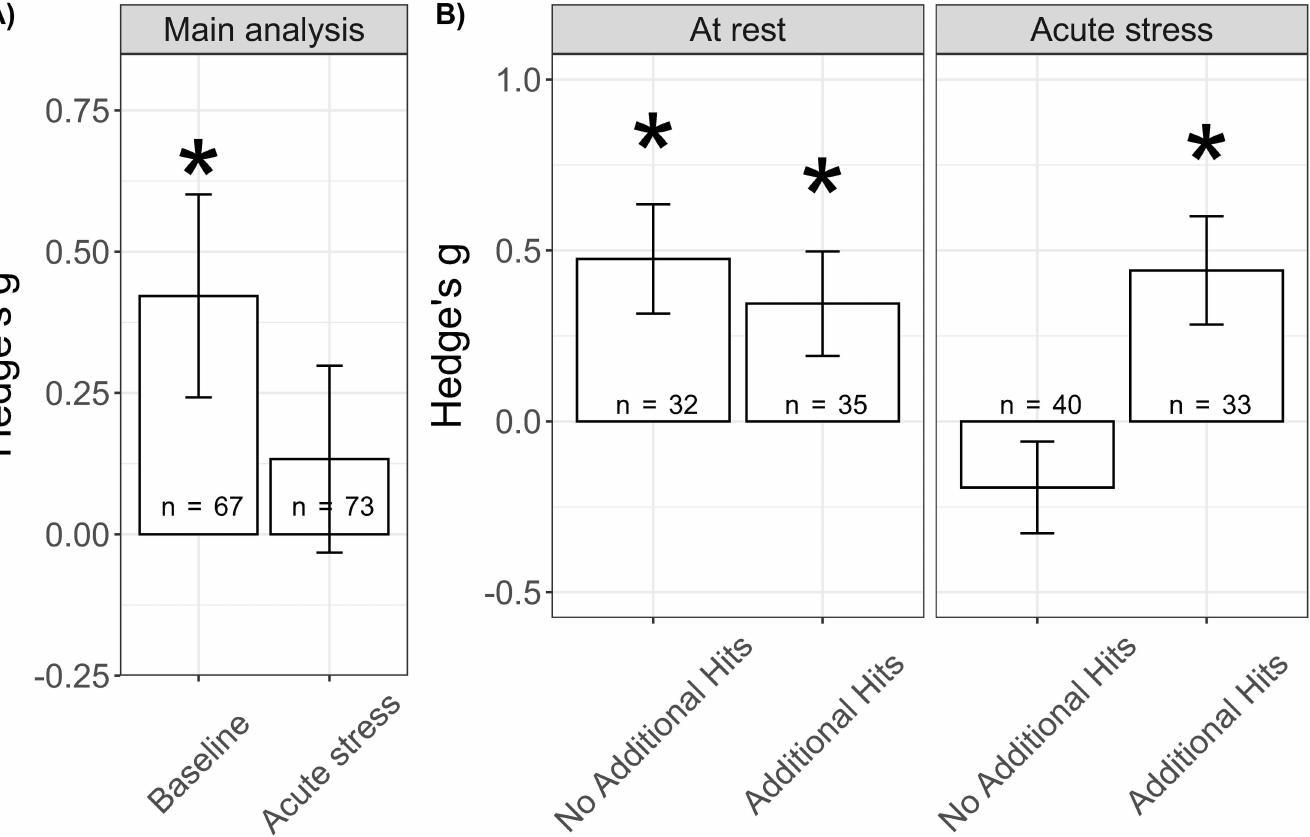
Fig 4. Main and subgroup analyses. A) Effects of ELA on cFos expression in male rodents at rest and after an acute stressor. B) Subgroup analysis for absence (No Additional Hits) or presence (Additional Hits) of additional negative life events. Of note, control and experimental animals always differed only in the presence/absence of ELA. Therefore, in the ‘Additional Hits’ comparison, also control animal experienced the additional negative life events. � p <